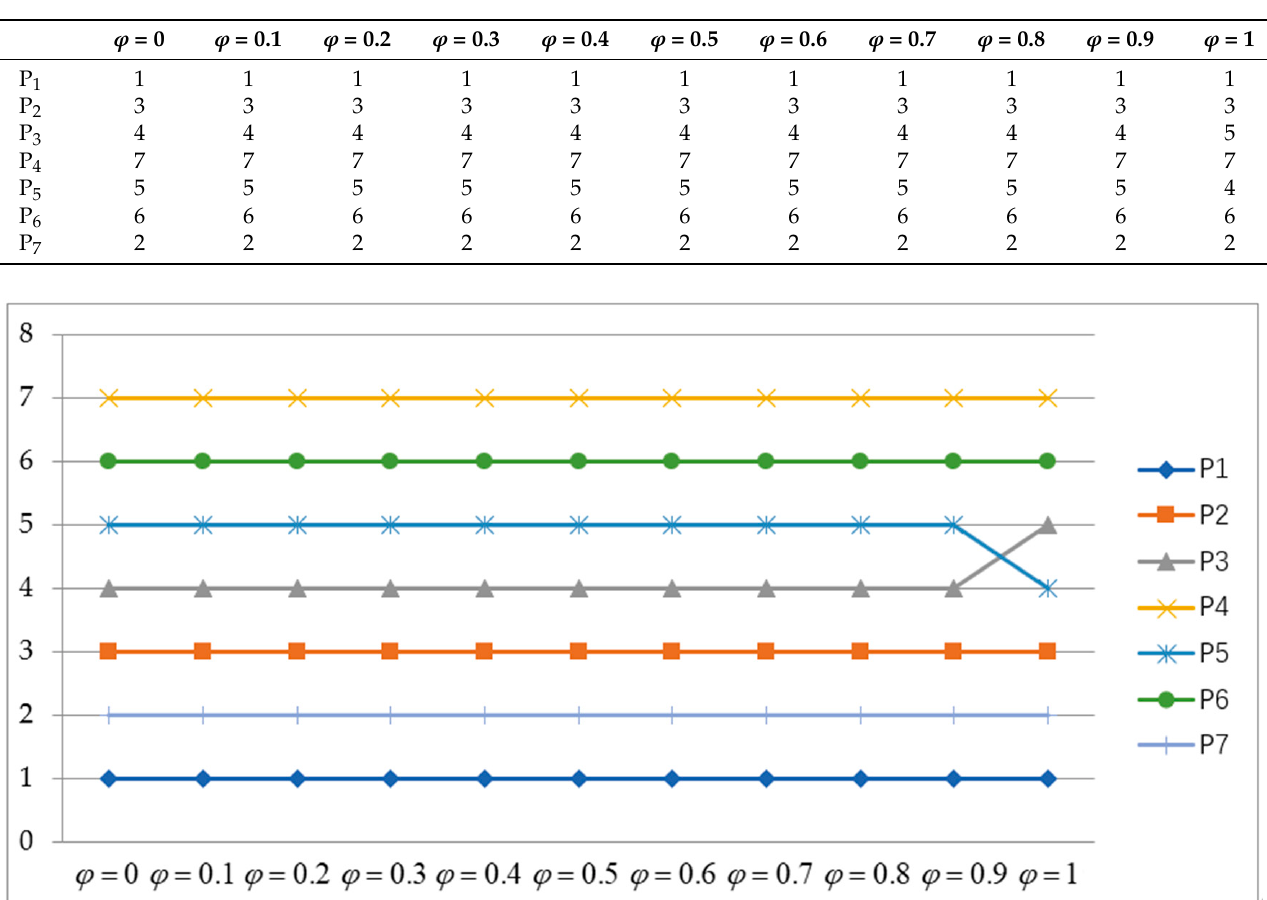
Figure 2. The ranking change of decision results under different parameter ϕ